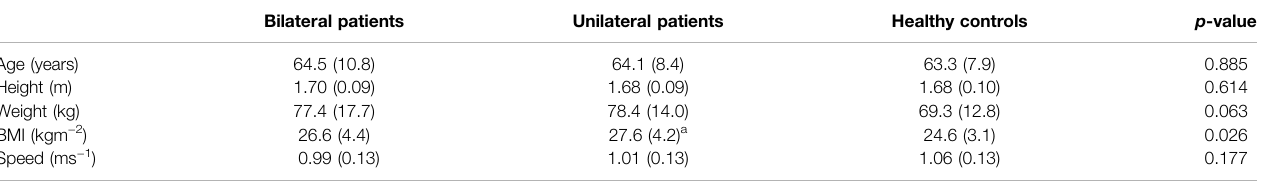
TABLE 1 | Anthropometric data and walking speed of patients and healthy